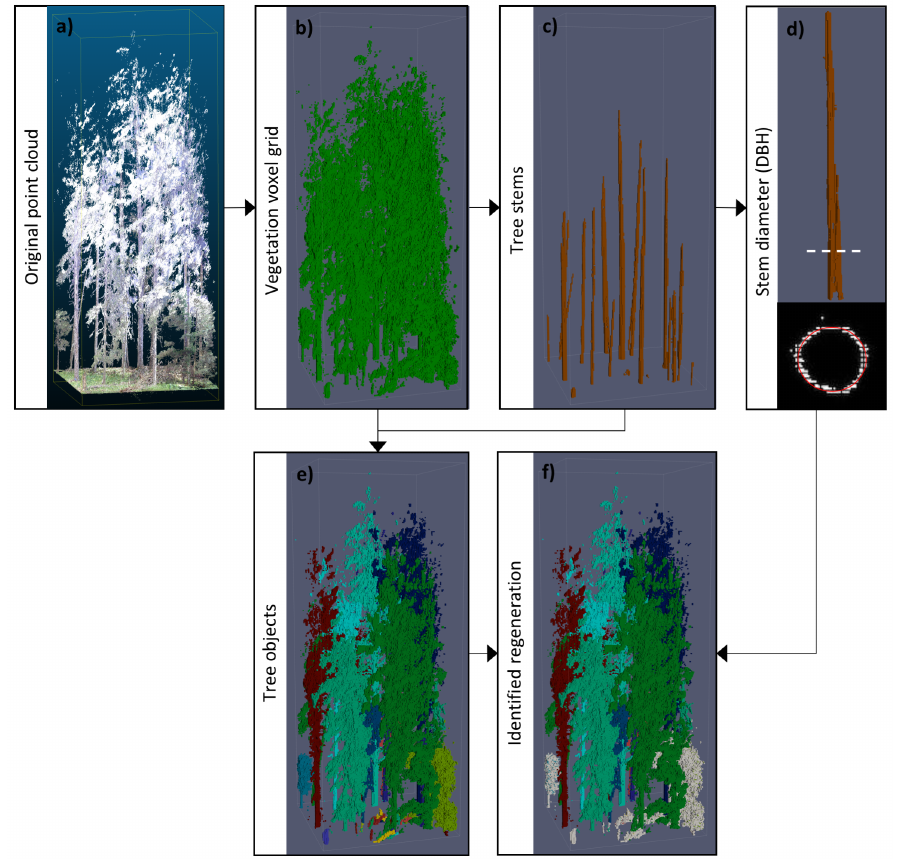
Figure 2. Illustration of the intermediate results of the overall workflow for an example plot quadrant. Image ( a ) shows the original normalized point cloud which was overlaid with RGB information for visualisation. Image ( b ) depicts the binary vegetation information after removing ground points and converting the data to a voxel grid. From the vegetation volume the tree stems were detected in image ( c ). The DBH was directly derived from the tree stems in image ( d ). The tree stems were also used as priors for segmentation of the vegetation volume into individual tree clusters in image ( e ). Image ( f ) shows the regeneration in light grey which was identified from the individual tree clusters by using DBH information and tree